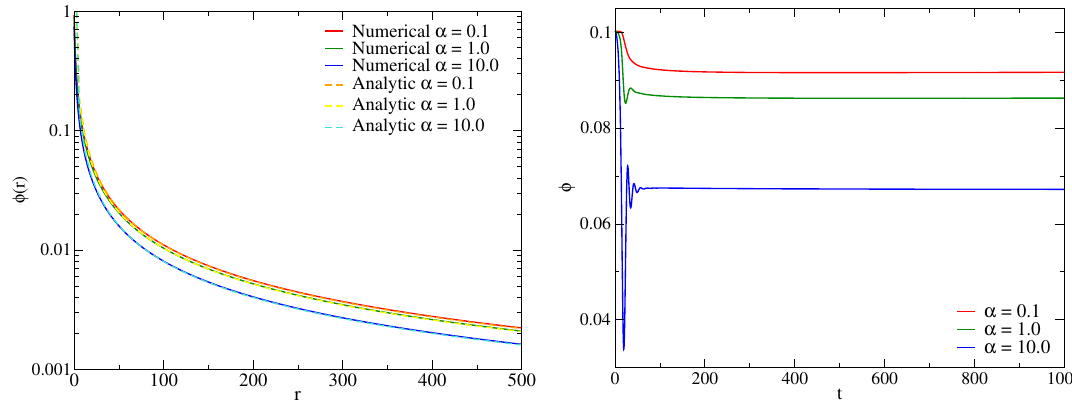
Figure 7 . (Left panel) Radial pro(cid:12)le of the scalar (cid:12)eld (cid:30) ( r ) at t = 1000 for the initial data consisting of a GMGHS BH with q = 1 : 1, in three models with di(cid:11)erent (cid:11) . There is an excellent matching between the pro(cid:12)le obtained from the numerical evolution and the pro(cid:12)le of a AAM BH with a slightly larger q and smaller Q s . (Right panel) Time evolution of the amplitude of the scalar (cid:12)eld extracted at r 0 = 11 : 09.